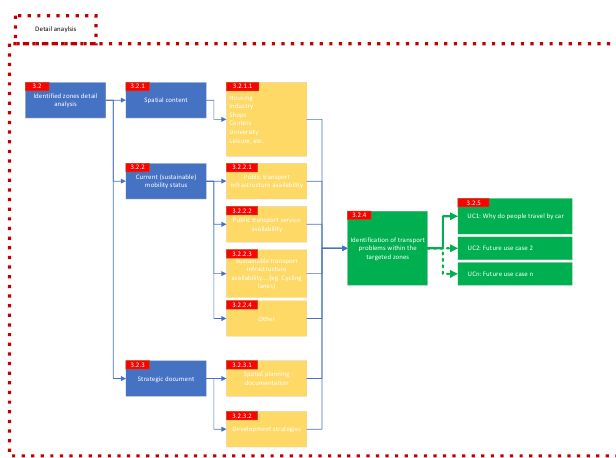
Figure 3. Detail analysis steps